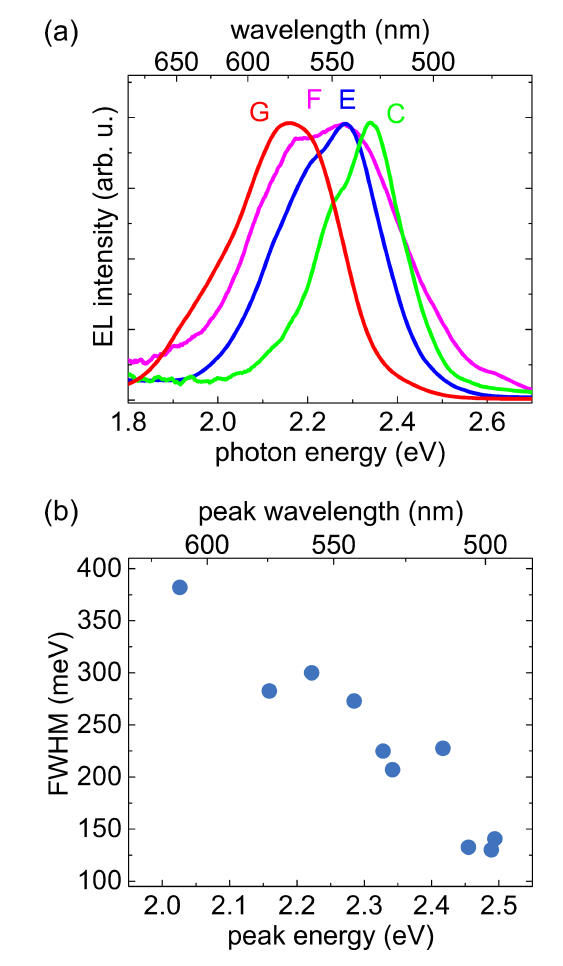
Figure 4: (a) Normalized EL spectra at various measurement points, including NW C for a driving current of 100 nA (ca. 1.3 kA/cm 2 ). (b) FWHM of the EL spectra of single-NW LEDs as a function of their peak emission energy.